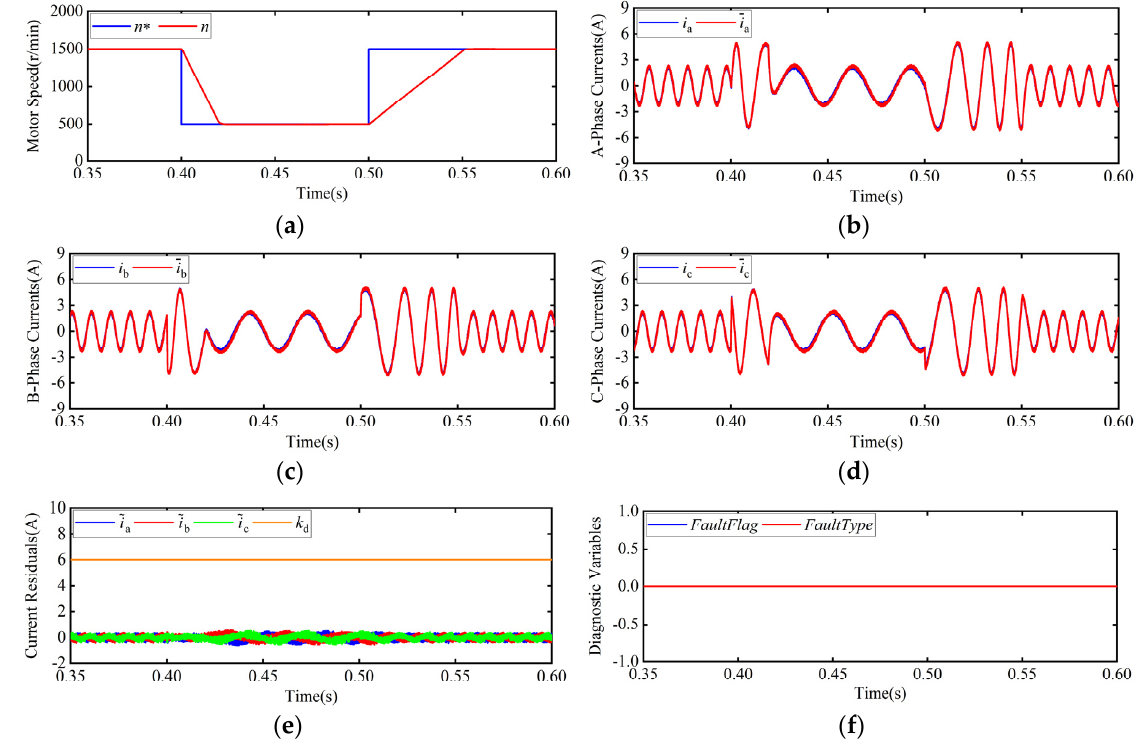
Figure 8. Motor operation in speed variations: ( a ) Motor speed; ( b ) A-phase currents; ( c ) B-phase currents; ( d ) C-phase currents; ( e ) current residuals; ( f ) diagnostic variables.